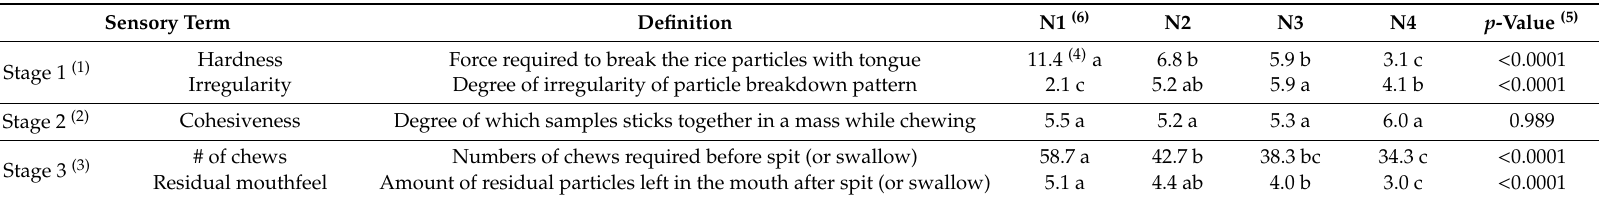
Table 4. Descriptive sensory texture analysis results on Nuroongji